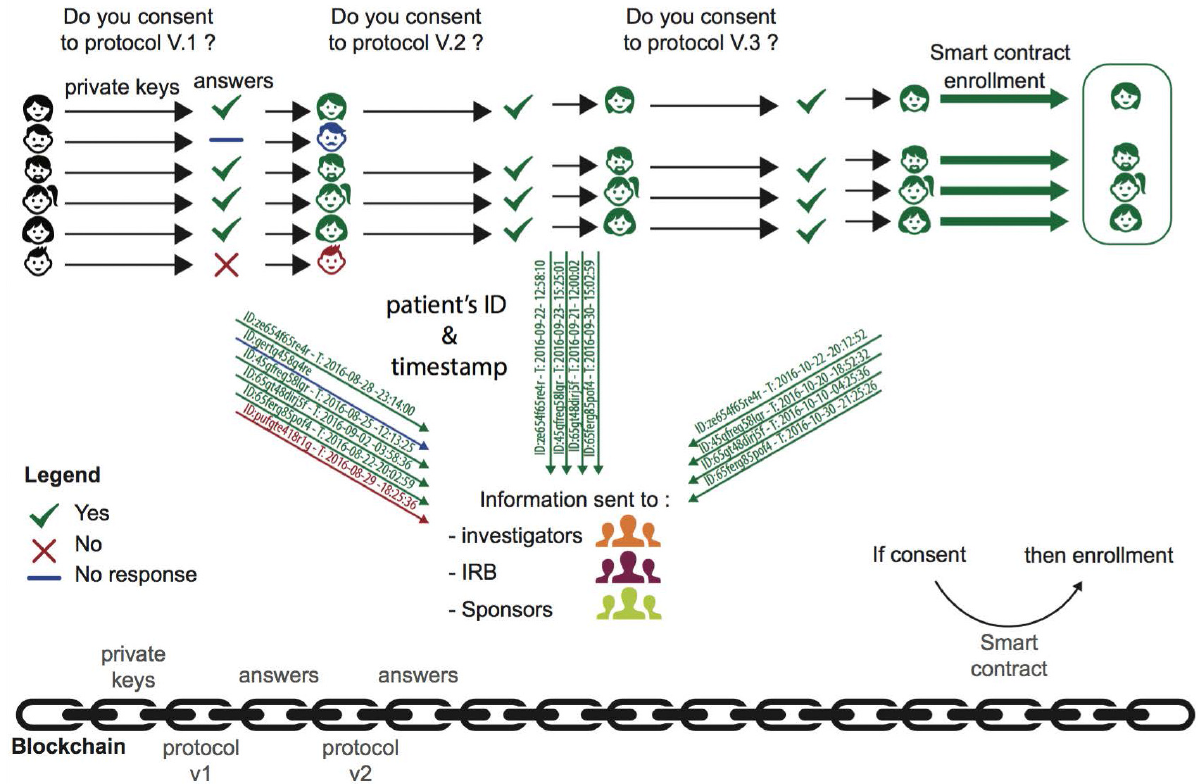
Figure 1. Consent collection Blockchain